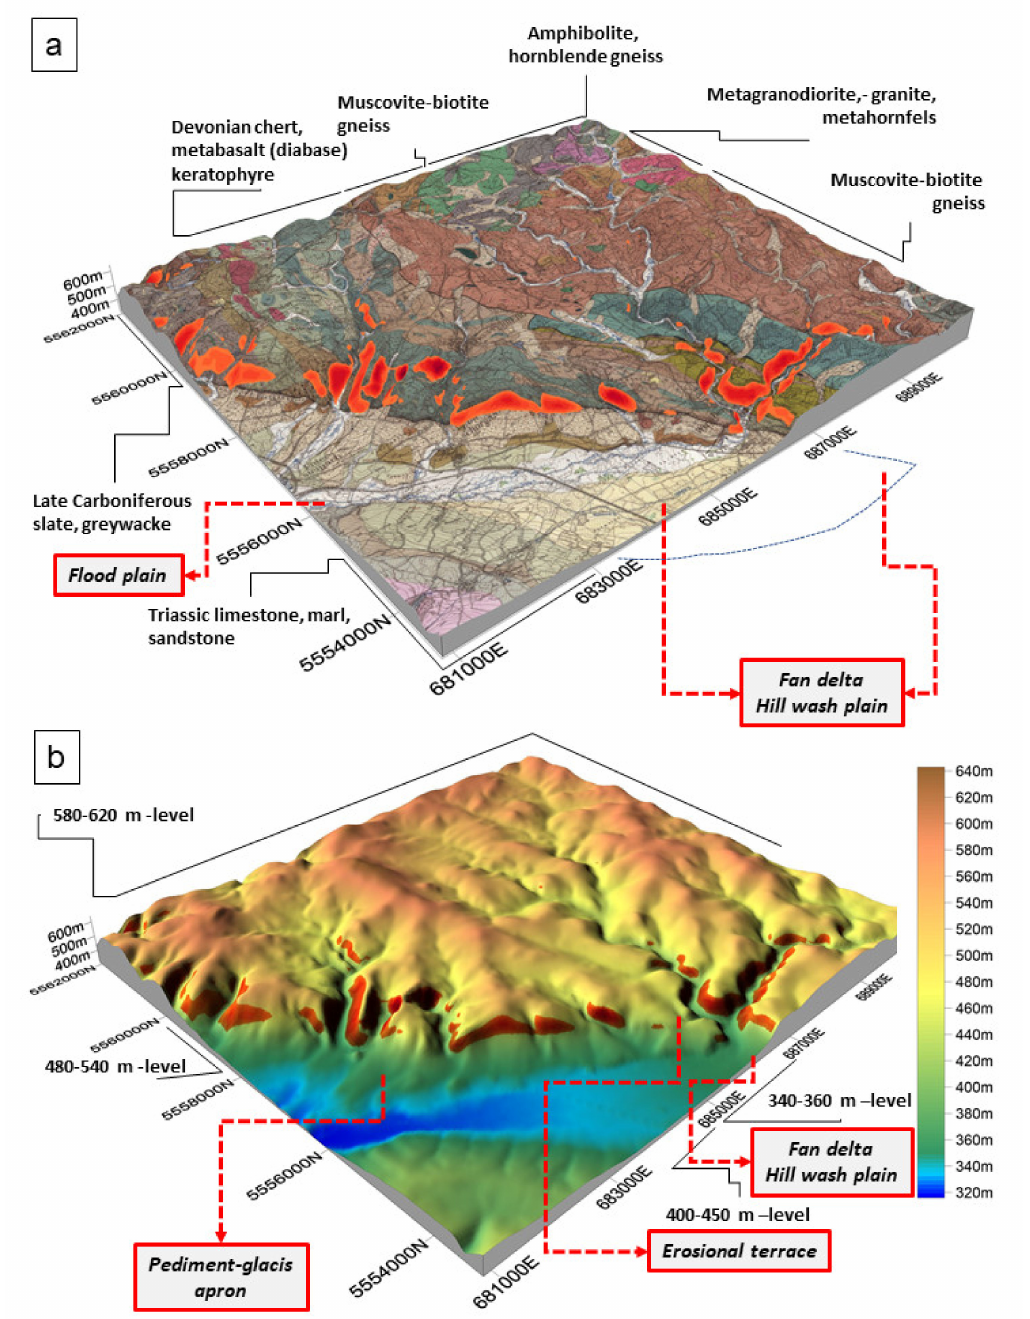
Figure 4. The drainage system of the Münchberg Gneiss Complex (MGC) (Table 1-LHG-type). For legend see Figure 3; ( a ) Geology and the geomorphological setting. Blue stippled line marks the fan onto the hillwash plain; ( b ) Excerpt of the topography and the level of paleosurfaces of ( a